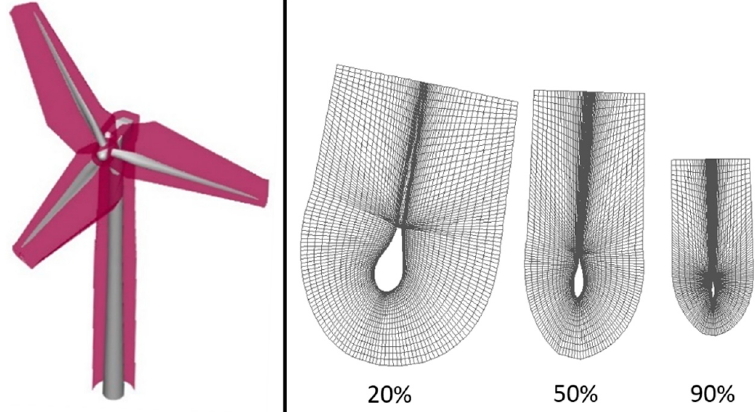
Figure 2. ( left ) Overview of the body-fitted mesh around blades and supporting structures with the overset borders in red, and ( right ) sections of the mesh around each blade, taken at different spanwise positions.